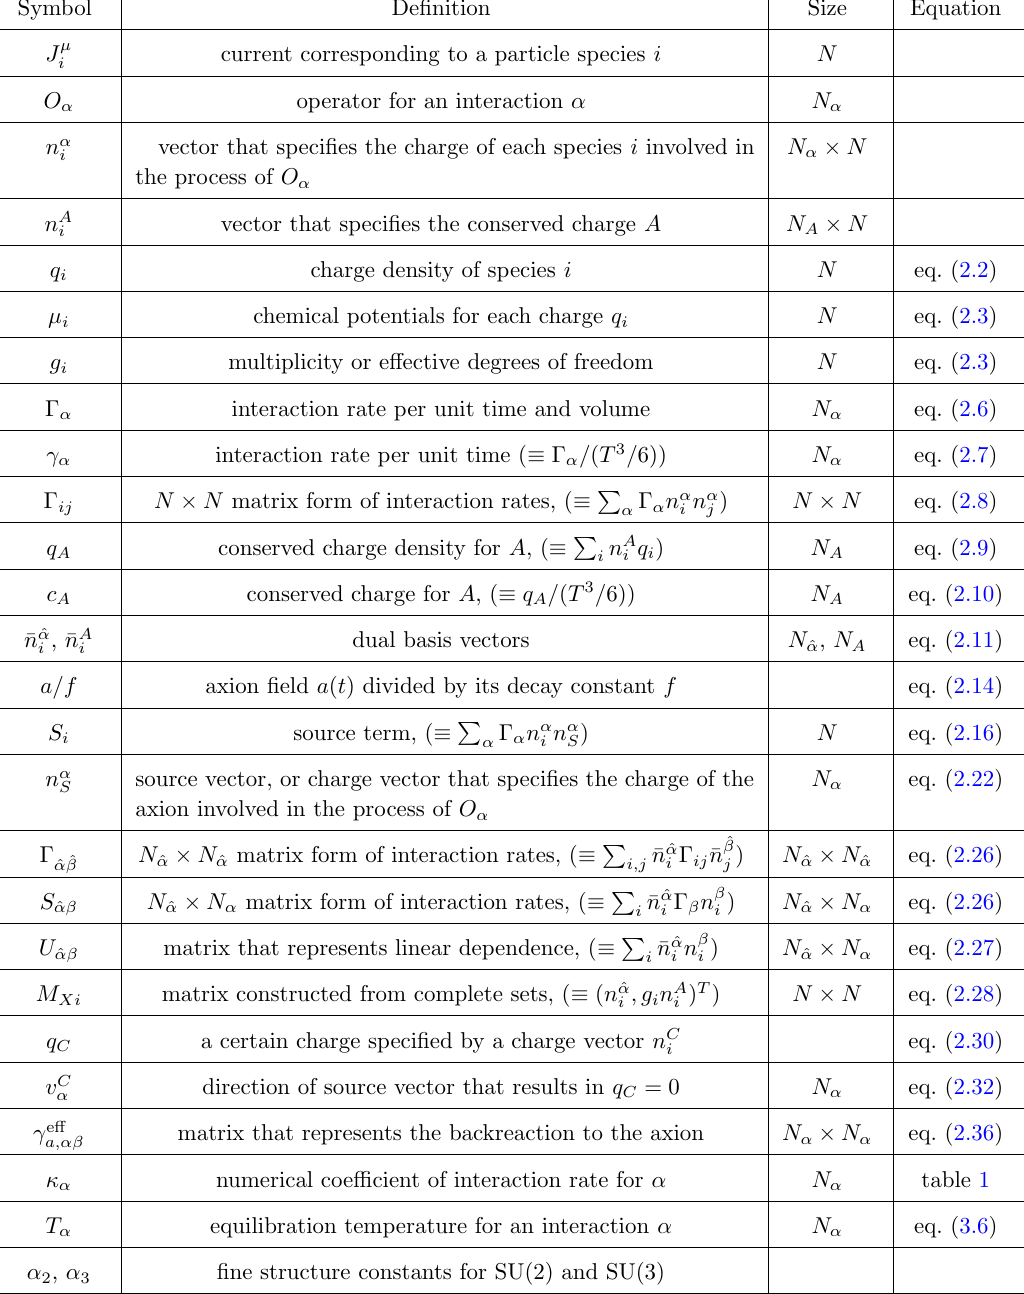
Table 2 . De(cid:12)nitions of